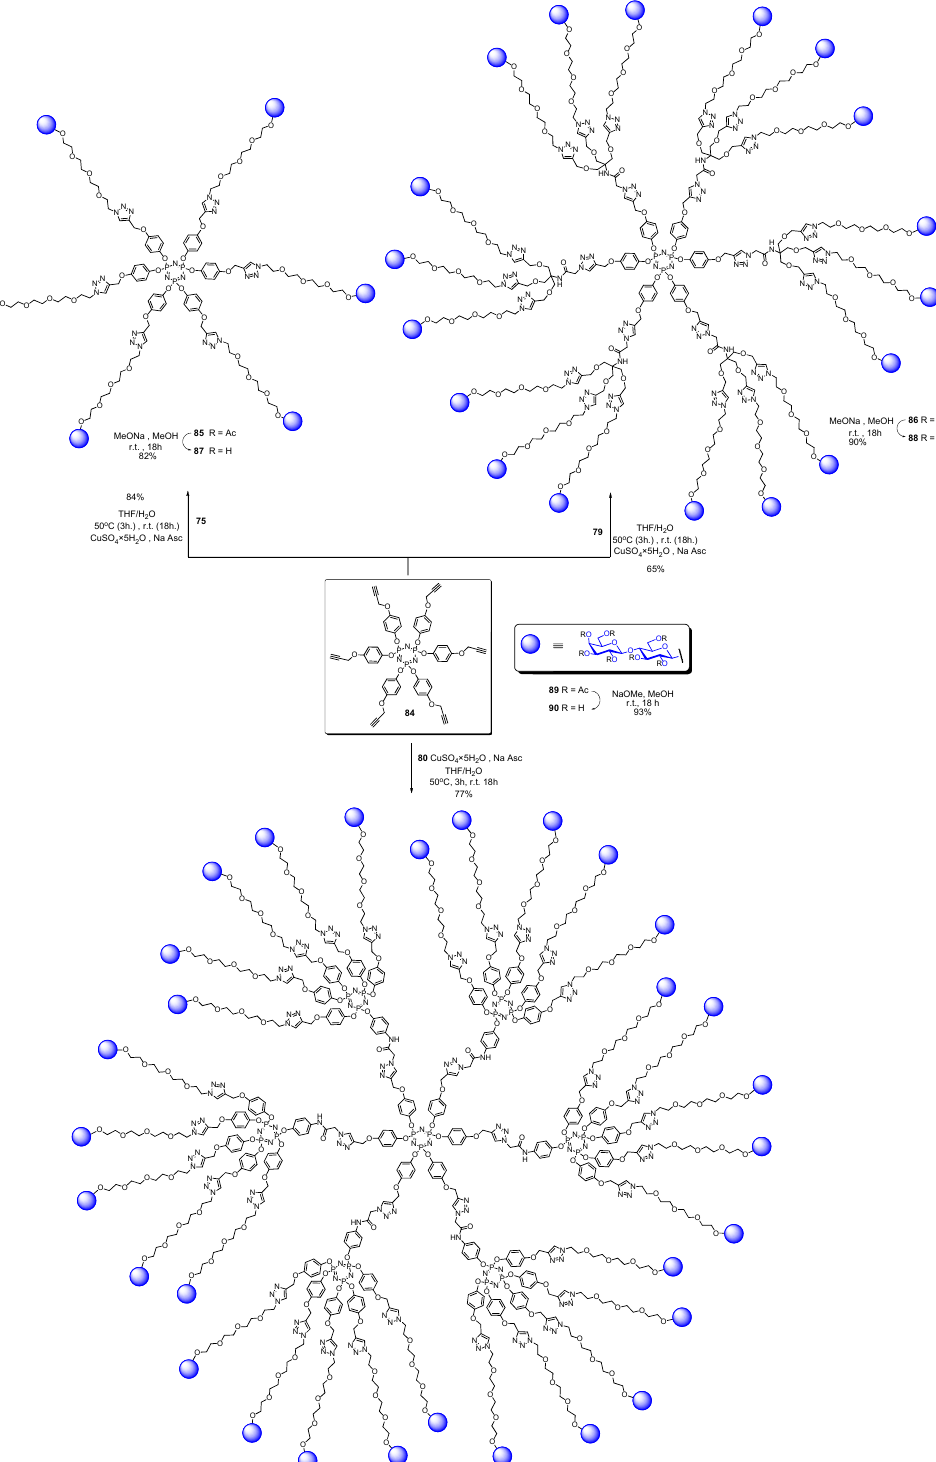
Molecules 2016 , 21 , 629 (Scheme 20) starting from thiolated pentaerythritol and hexasubstituted benzene derivatives [126]. The above structures were shown to have low polydispersity PDI (Mw/Mn) (<1.08) with molecular weight ranging from 5 kDa to more than 75 kDa [126].